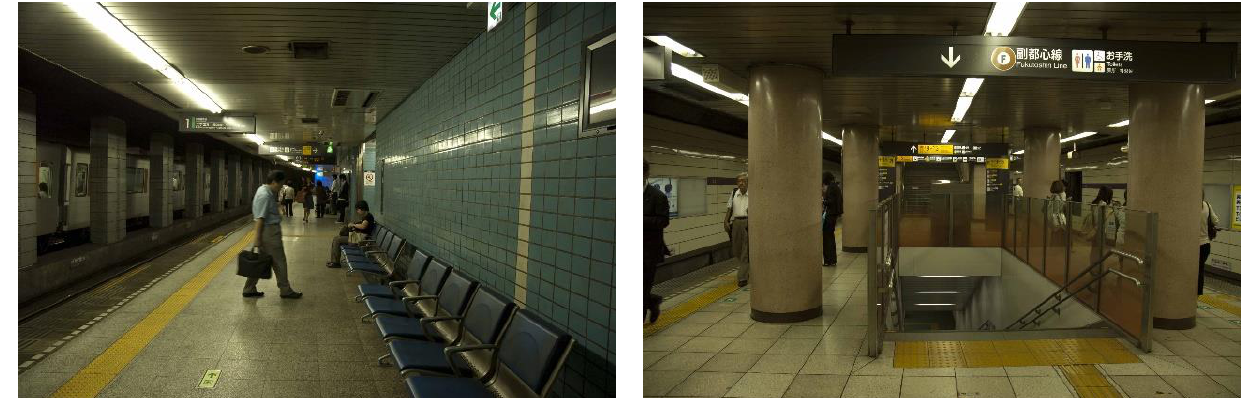
Figure 6. Structural comparison between side platform and island platform ( left : No. 13, right : No. 10).